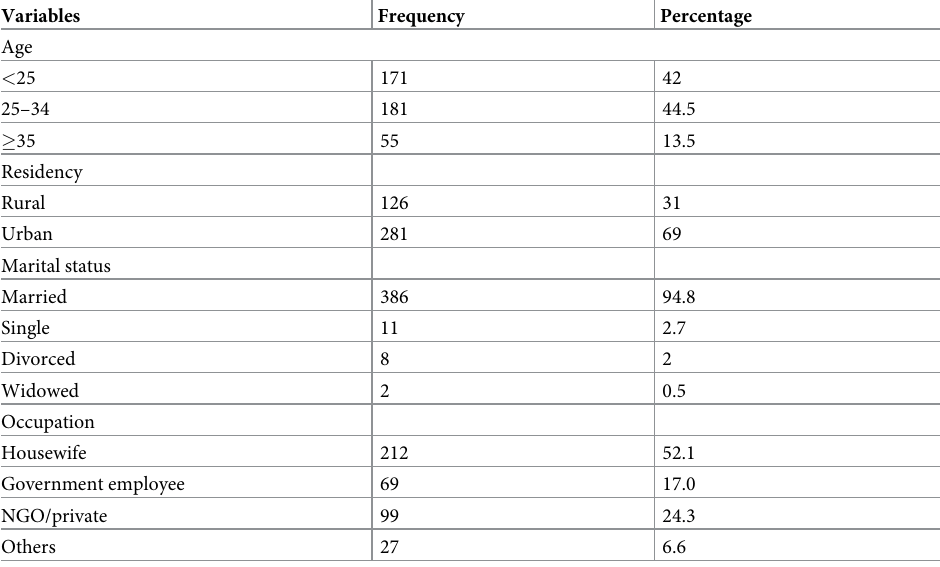
Table 1. Socio-demographic characteristics of the study participants, Arba Minch town, south Ethiopia, 2019, (n =